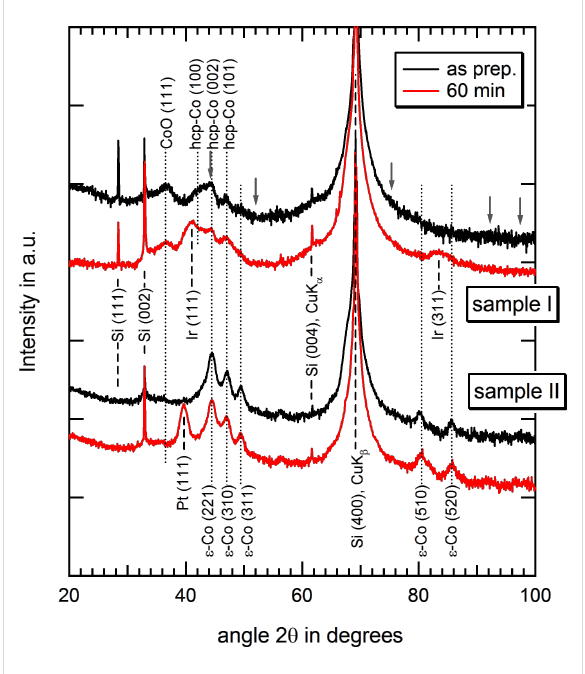
Figure 4: XRD measurements of sample I (top) and sample II (bottom) before (red) and after (blue) hydrogen-plasma treatment. Particle species I shows an hcp order while sample II is crystallized in the ε -phase. No evidence of an fcc-Co phase can be found; the gray arrows in the top plot indicate the expected peak positions. Further, each phase maintains its stability during plasma